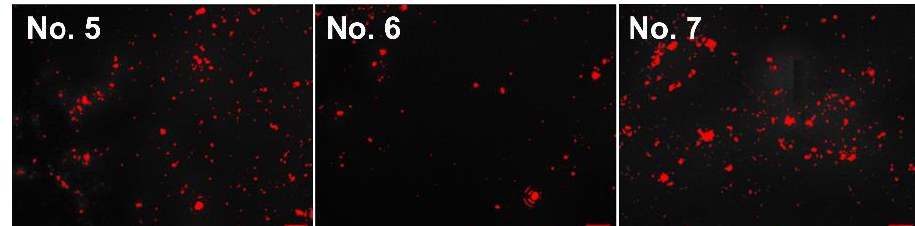
Figure 6. Images of the micro-organisms attached to specimens No. 5 – 7.